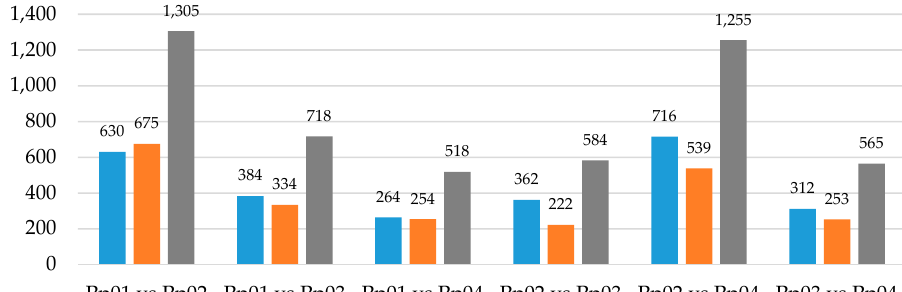
Figure 1. Number of differentially expressed genes (up and down) uniquely for each comparison. Tests up-regulated are shown in blue, tests down regulated are shown in orange and the total number of tests is shown in